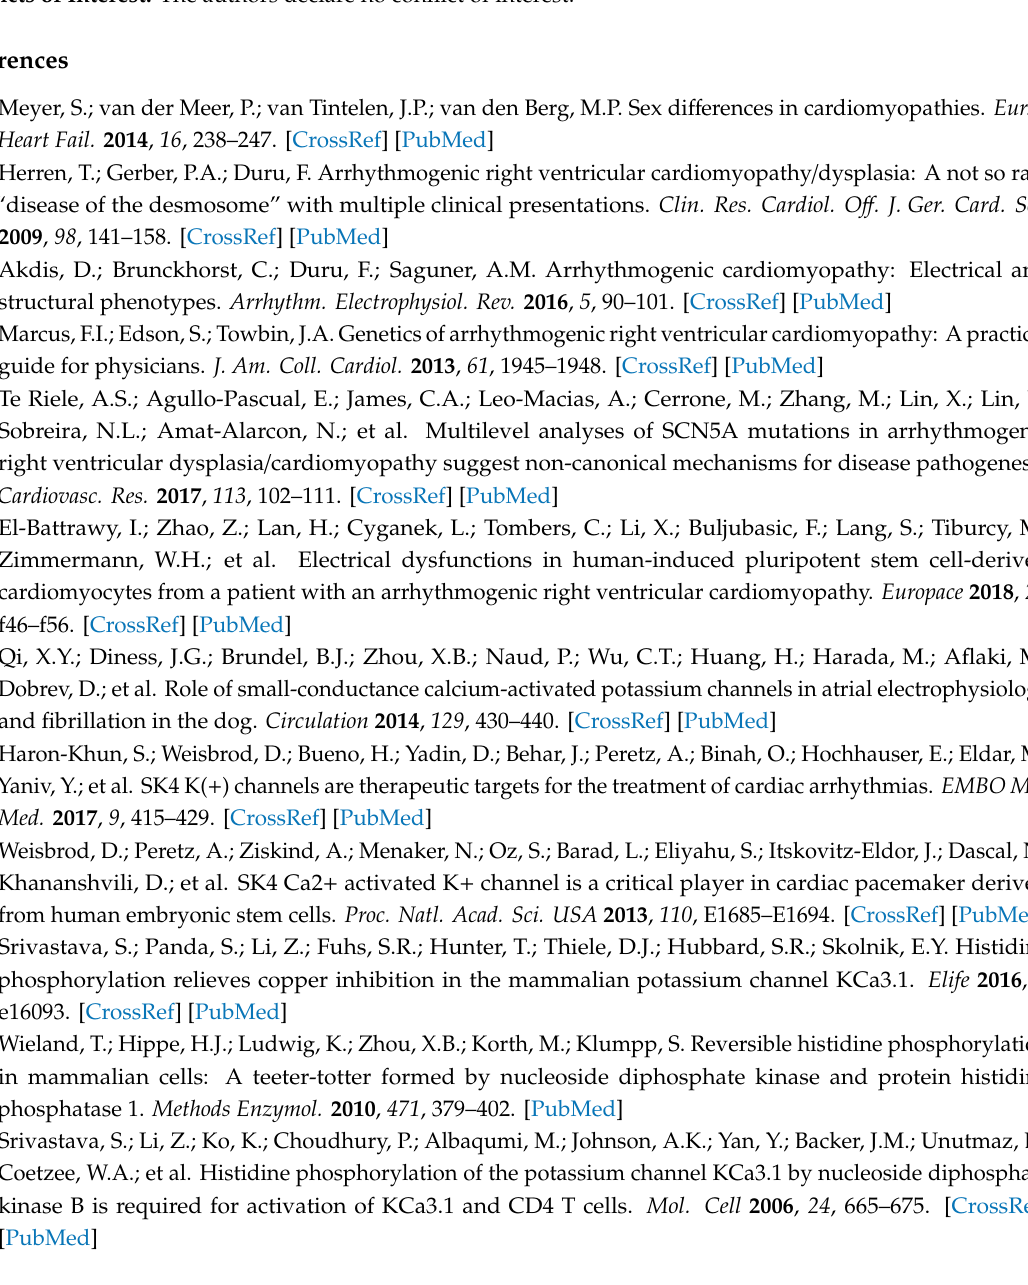
Figure S1: Expression of cardiac markers in ARVC-hiPSC-CMs. Figure S2: Assessment of the enzymatic activities of recombinantly expressed NDPK isoforms compared to catalytically inactive point